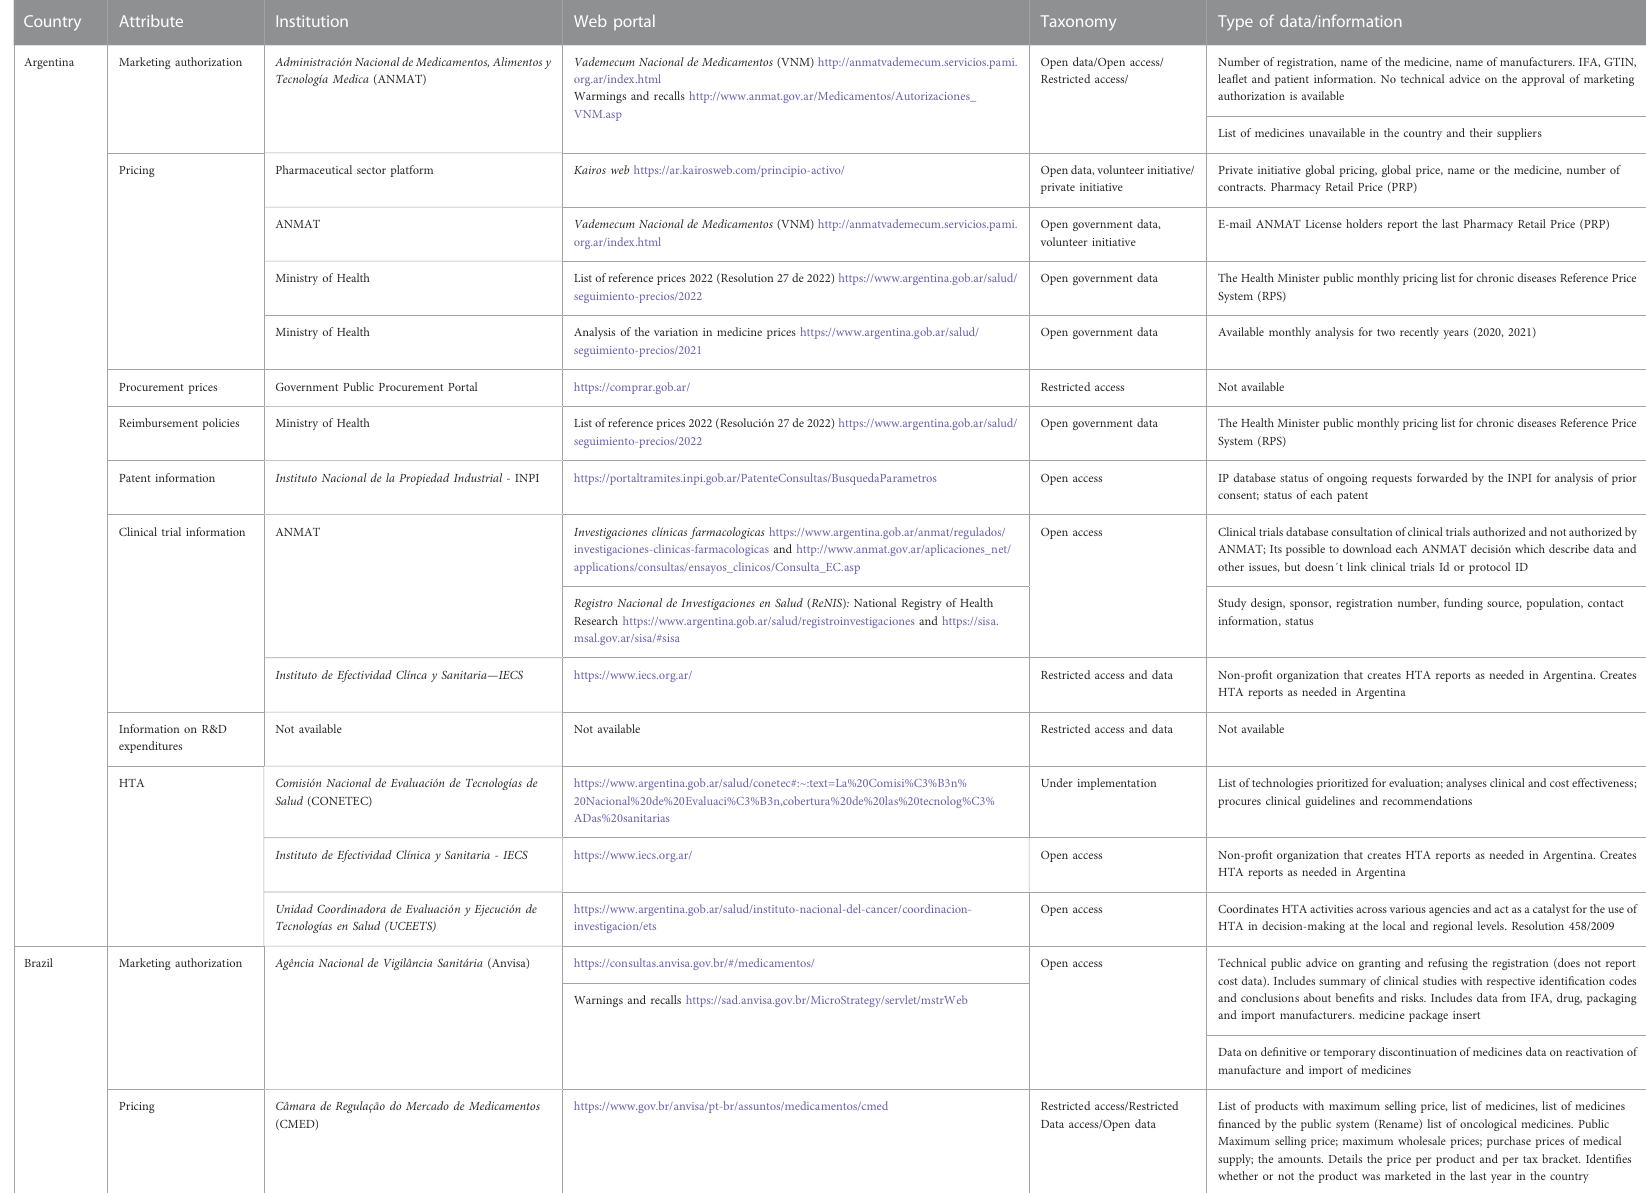
TABLE 2 Publicly accessible online registries of price and cost information in Argentina, Brazil, and Colombia.